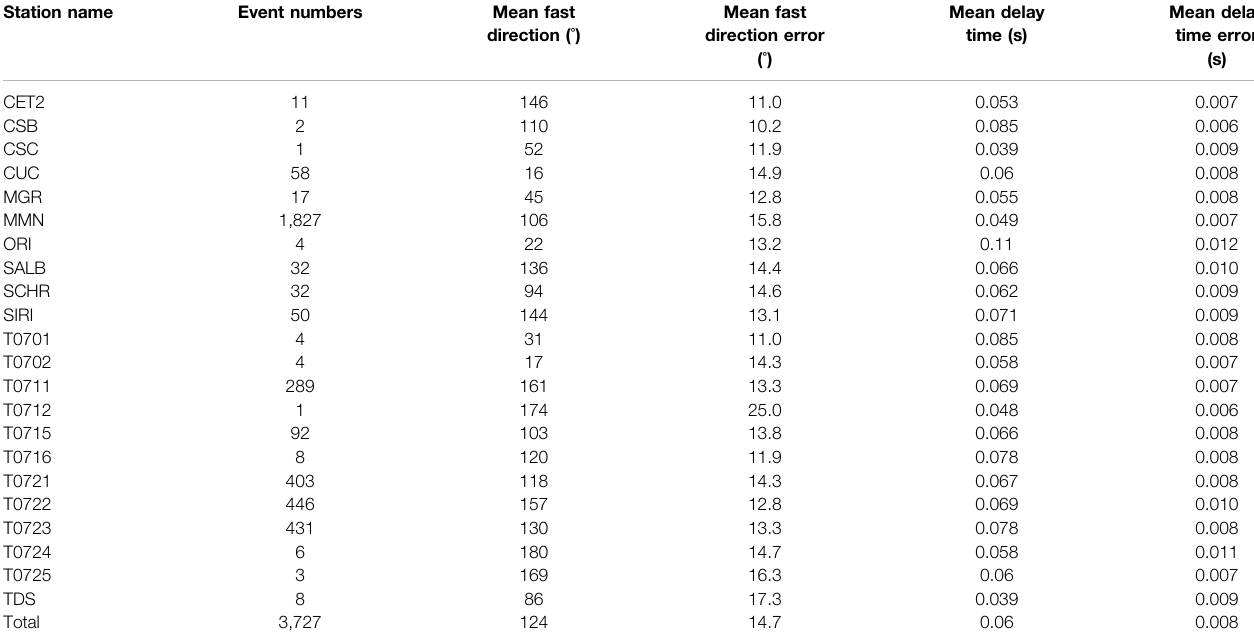
TABLE 1 | Averaged anisotropic results and their associated errors obtained at each used station. Station